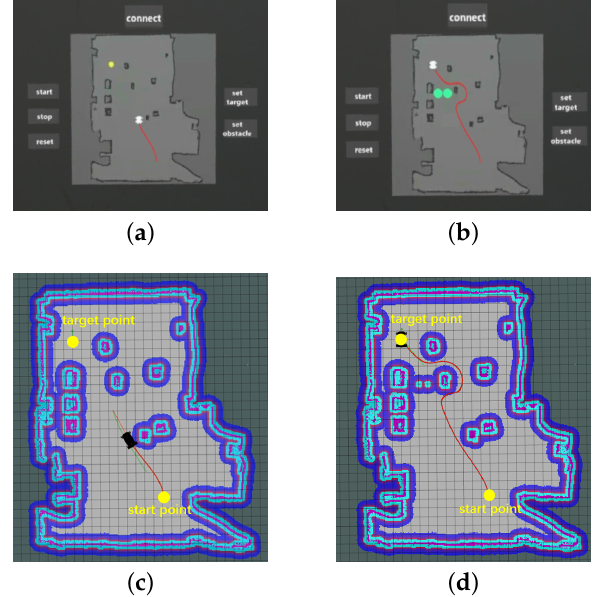
Figure 10. The trajectory in HoloLens and RViz before and after adding virtual obstacles. ( a ) The scene in HoloLens before adding virtual obstacles. ( b ) The scene in HoloLens after adding virtual obstacles. ( c ) The scene in RViz before adding virtual obstacles. ( d ) The scene in RViz after adding virtual